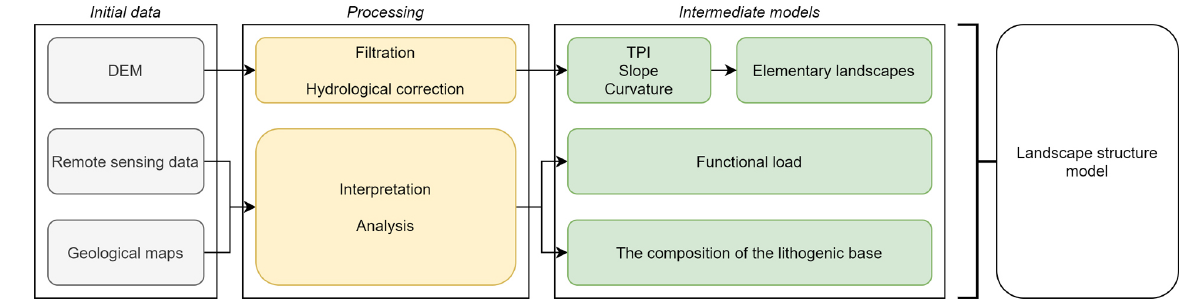
Fig. 3. Scheme of creating a model of landscape